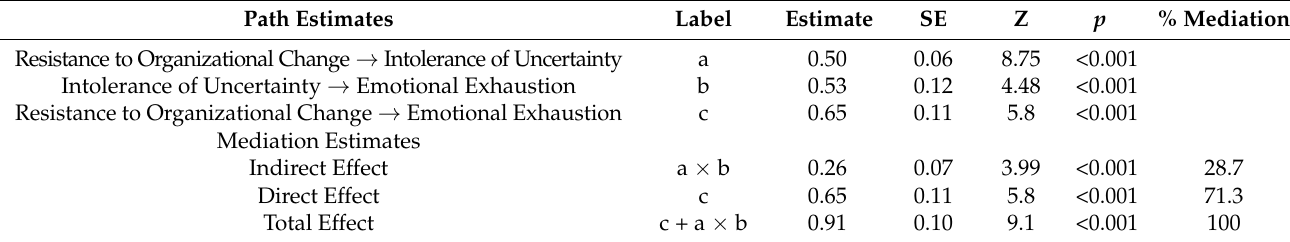
Table 5. Mediation